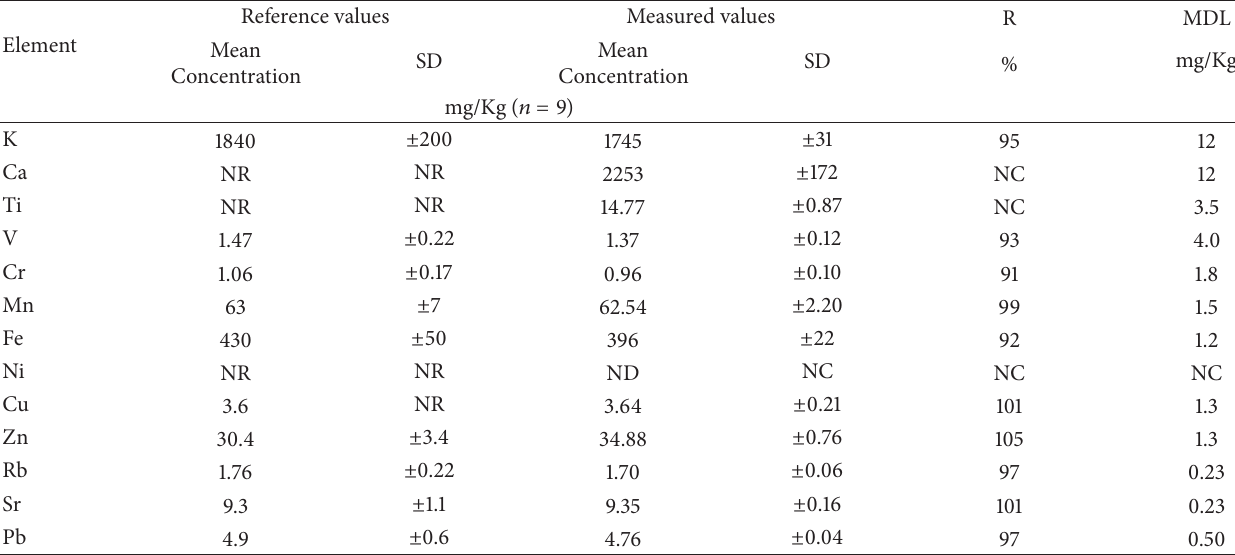
Table 3: Comparison between measured and reference elements concentration for the IAEA: Standard reference material: IAEA-336 Lichen. Element